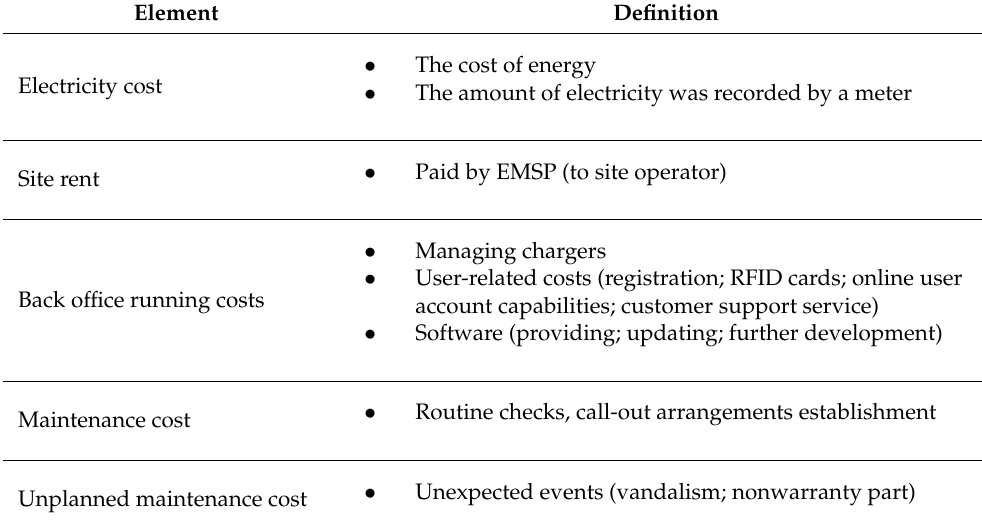
Table 7. Summary of OPEX parameter [2].